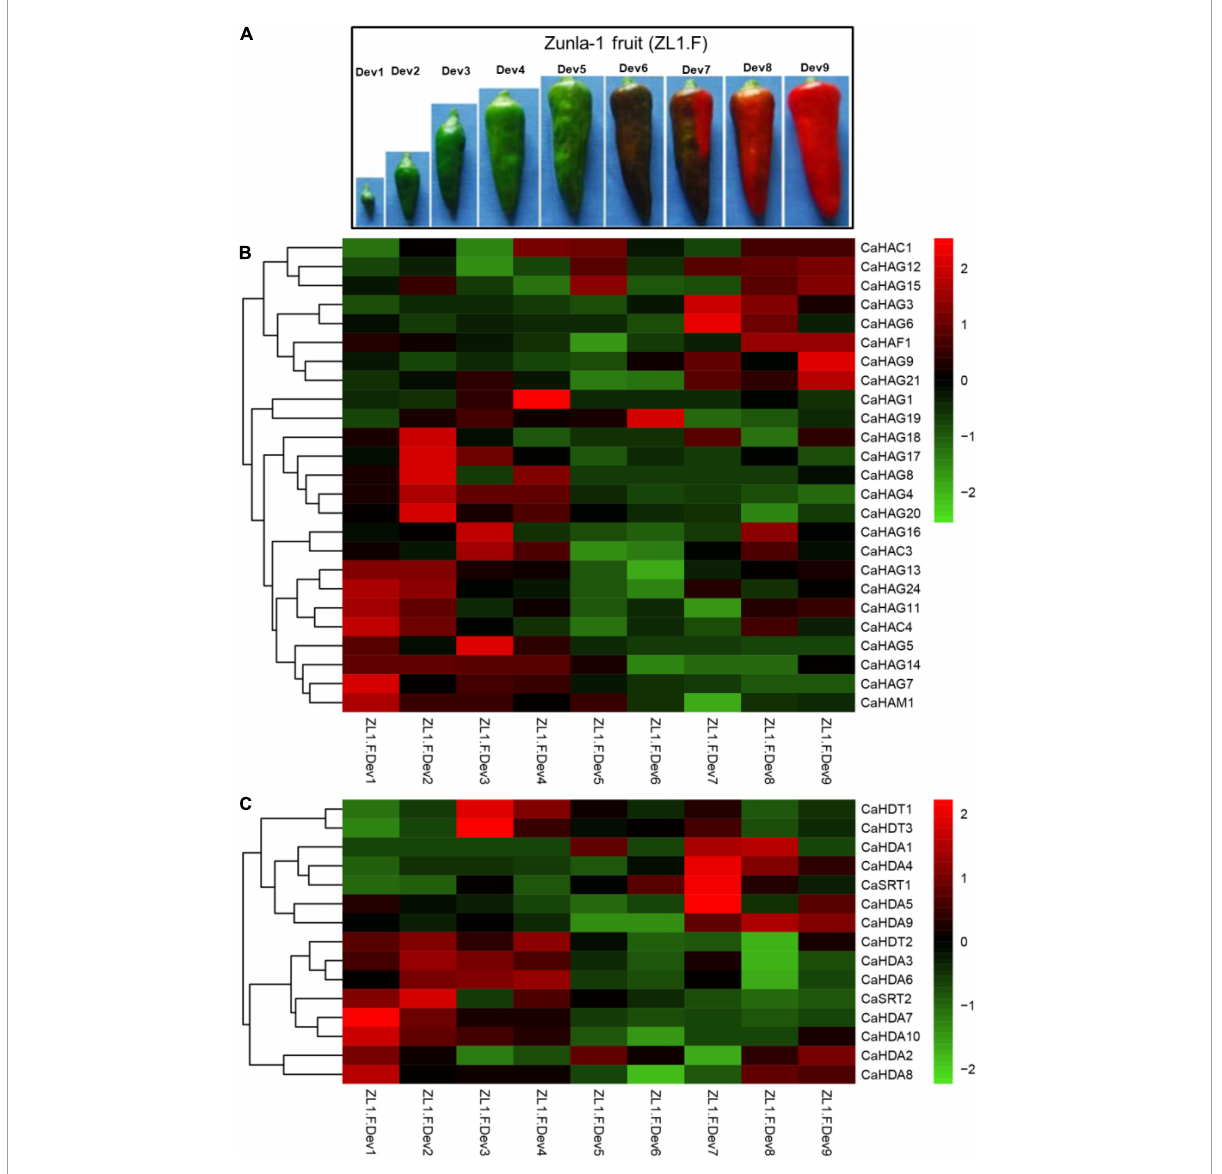
FIGURE4 Expression pattern of CaHATs and CaHDACs in pepper nine fruit developmental stages. (A) “Zunla-1” (ZL-1) fruit at nine different stages, including the whole development stages of pepper fruit. The expression of CaHATs (B) and CaHDACs (C) at nine different development stages is shown in (A) . The expression data were retrieved from “Zunla-1” transcriptome (Qin et al.,